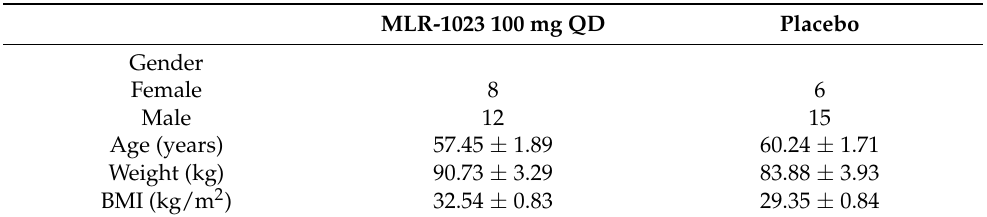
Table 1. Baseline characteristics of subjects. Values are mean ± SD.